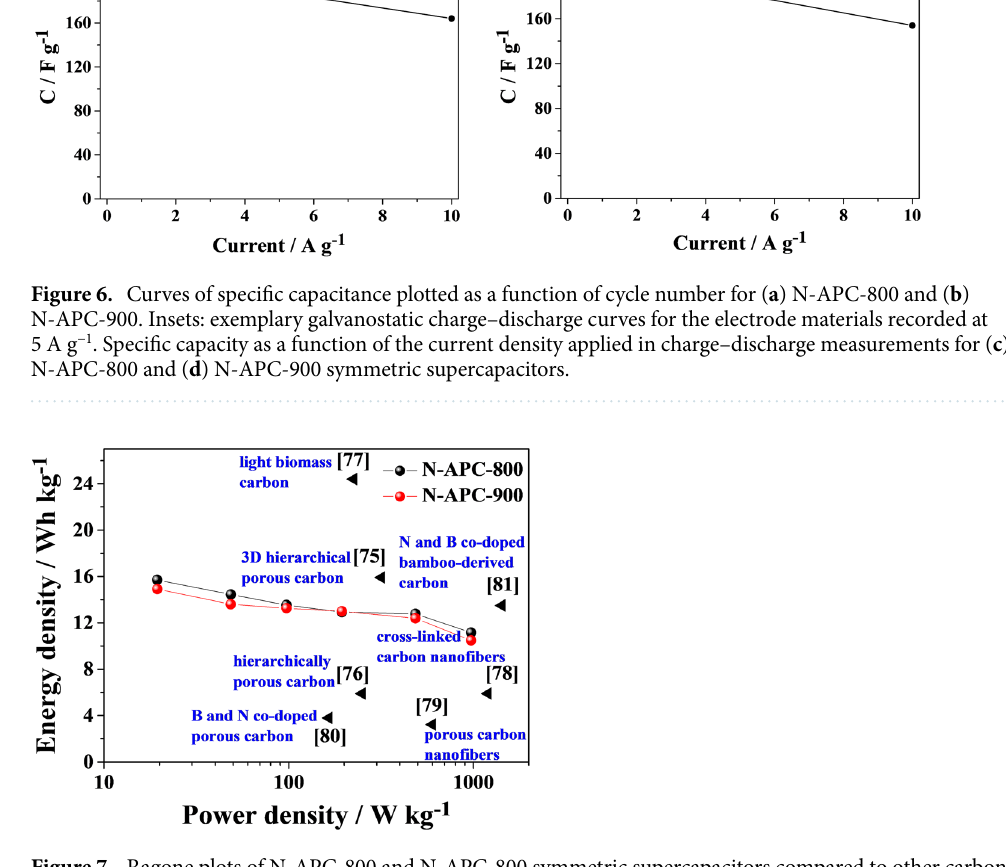
Figure 7. Ragone plots of N-APC-800 and N-APC-800 symmetric supercapacitors compared to other carbon- based